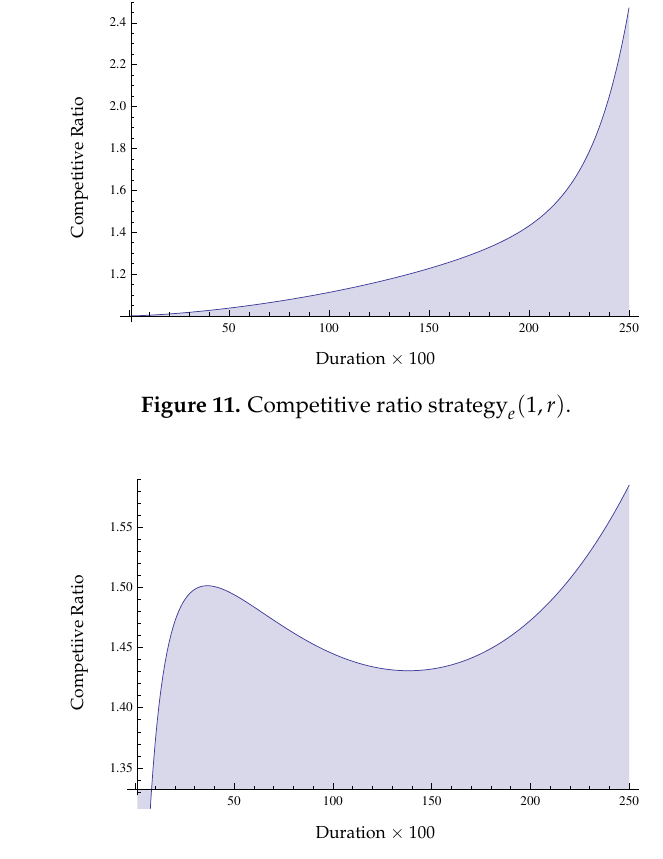
Figure 12. Competitive ratio strategy